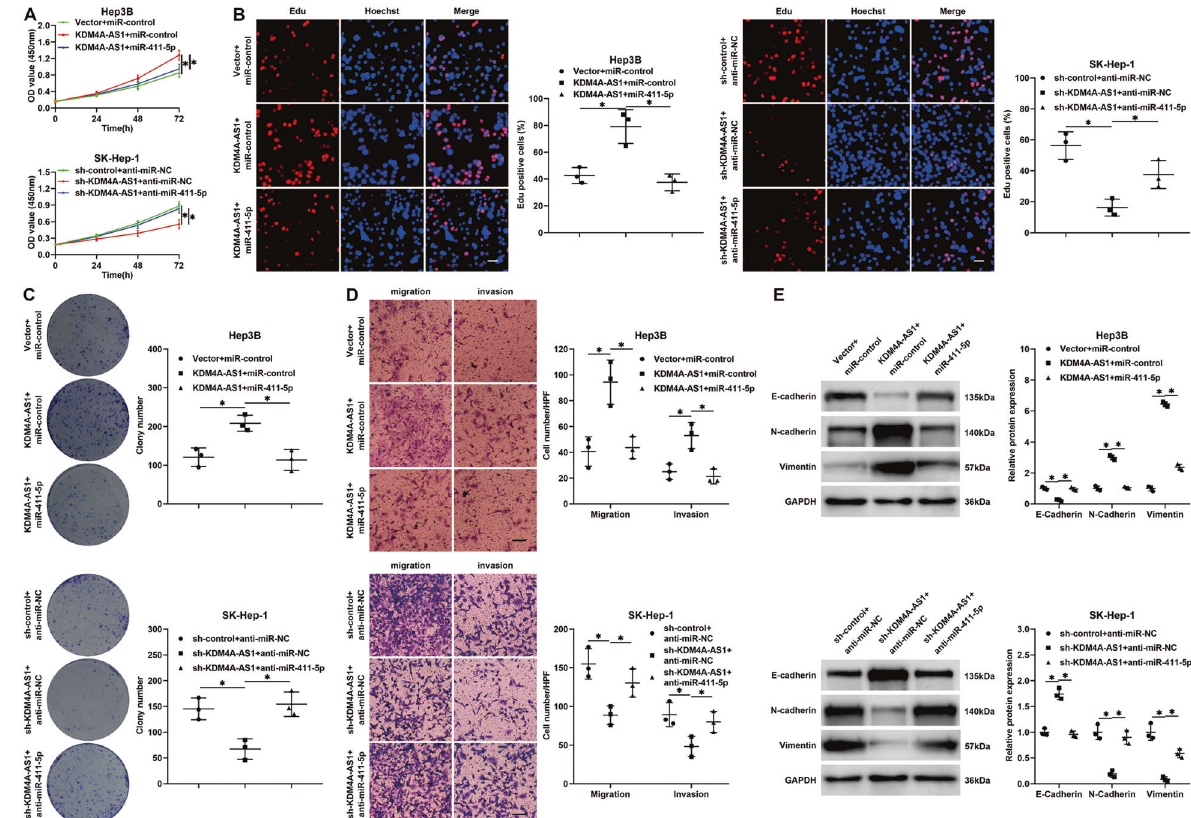
Fig. 5 miR-411-5p mediates the oncogenic effects of KDM4A-AS1 on HCC cells. Hep3B cells with KDM4A-AS1 overexpression were transfected with miR-411-5p mimics or control, while SK-Hep-1 cells with KDM4A-AS1 knockdown were transfected with miR-411-5p inhibitors or control. A CCK-8, B Edu (scale bars = 20 μ m), C colony formation, D transwell (scale bars = 100 μ m), and E western blotting assays were conducted to examine the proliferation, migration, invasion, and EMT process of HCC cells in different groups. Scale bar: 20 μ m for Edu results and 100 μ m for transwell results. * P <